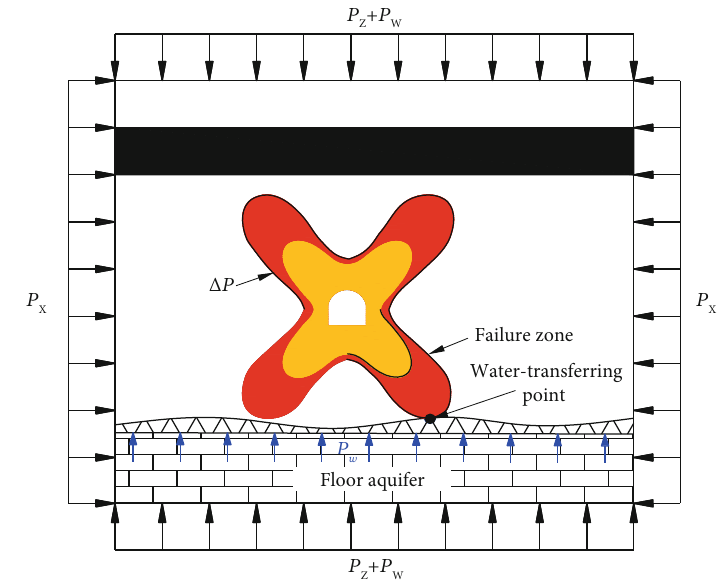
Figure 10: The schematic of “ butter fl y-shaped water inrush ” of the fl oor